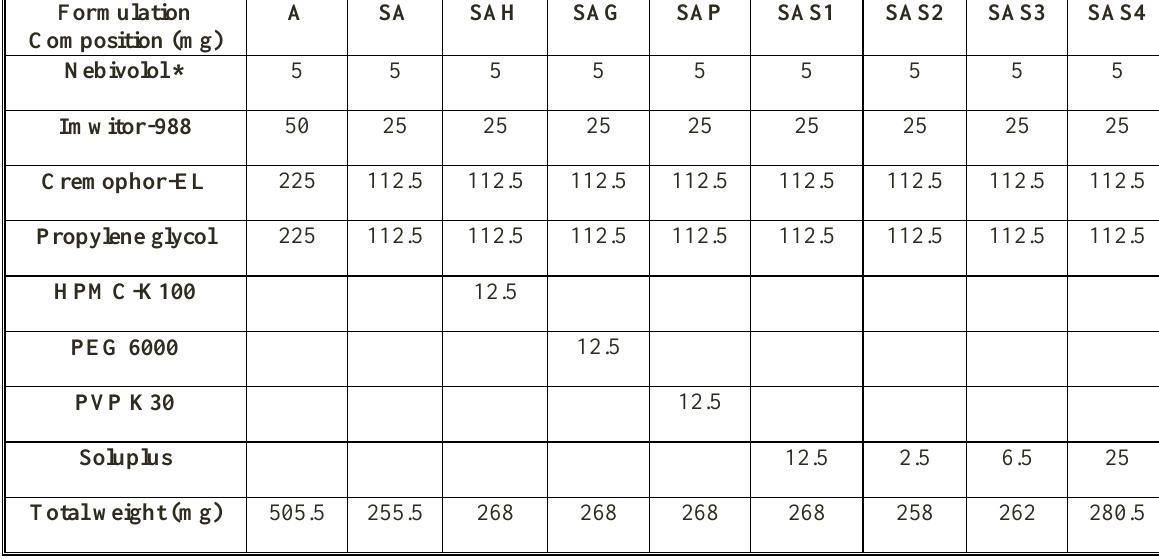
Table 1. Nebivolol-loaded Supersaturable Liquid Self-nanoemulsion Formulations.